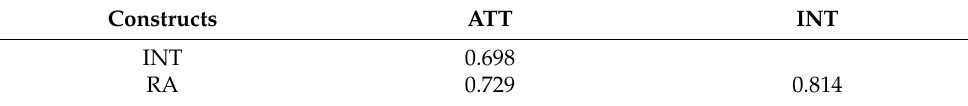
Table 9. Heterotrait–Monotrait Ratio (HTMT).